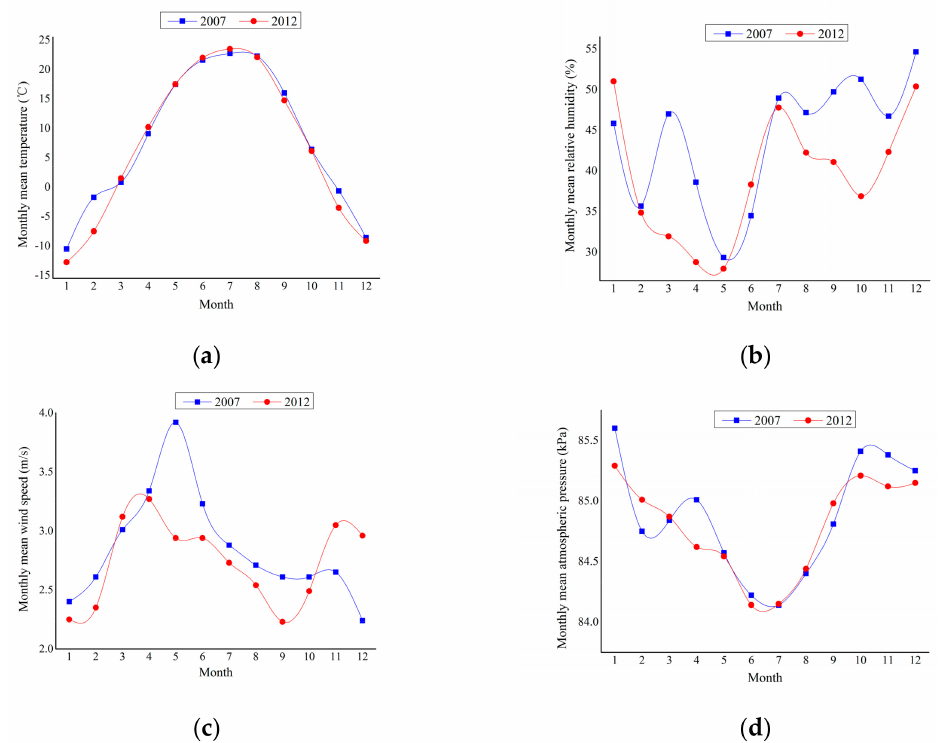
Figure 7. Monthly mean changes in climate between 2007 and 2012 in the HRB: ( a ) Temperature; ( b ) Relative humidity; ( c ) Wind speed; ( d ) Atmospheric